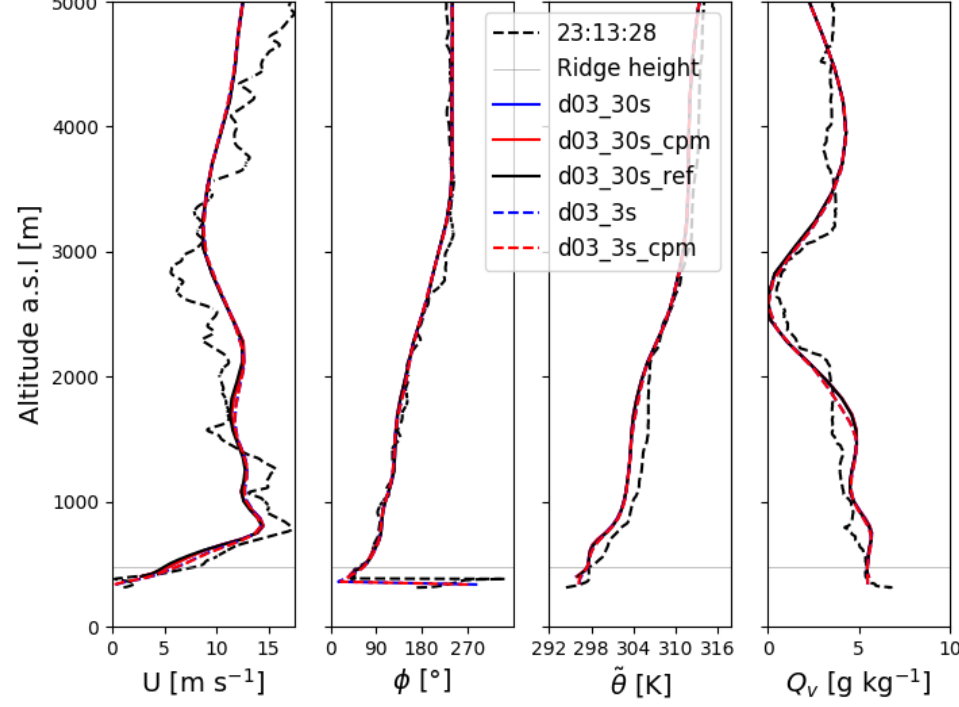
Figure 8. As in Figure 6 but comparing to a sounding released at 23:13:28 UTC 20 May